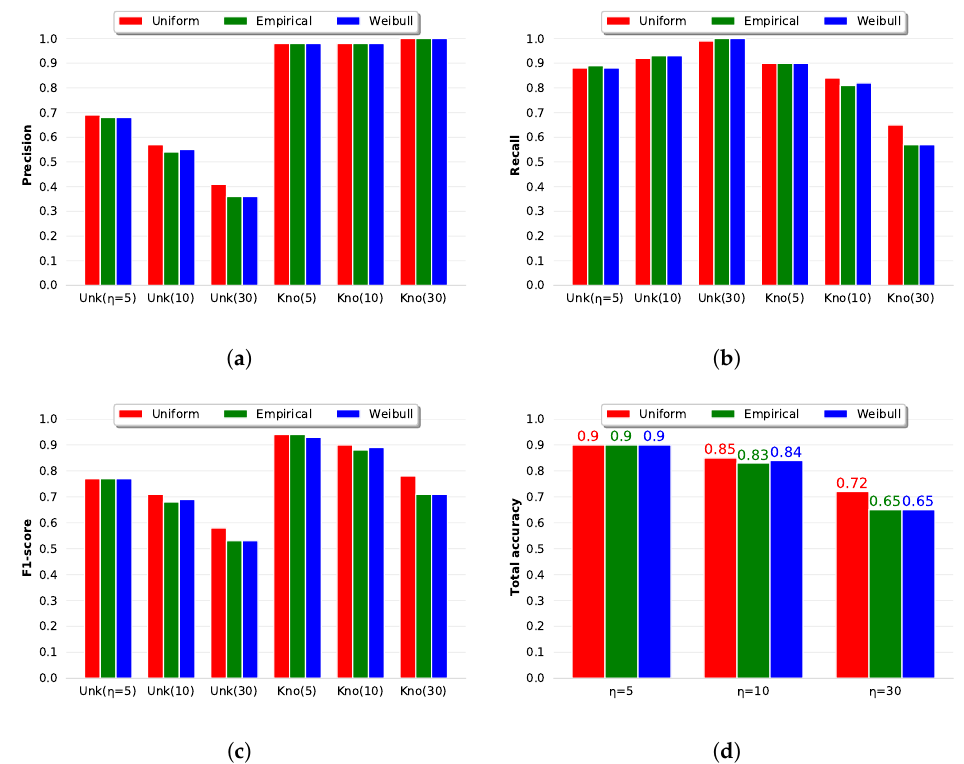
Figure 13. Classification reports obtained by η = ( 5,10,30 ) using Uniform, Empirical and Weibull CDFs: ( a ) Precision, ( b ) Recall, ( c ) F1-score, and ( d ) Total